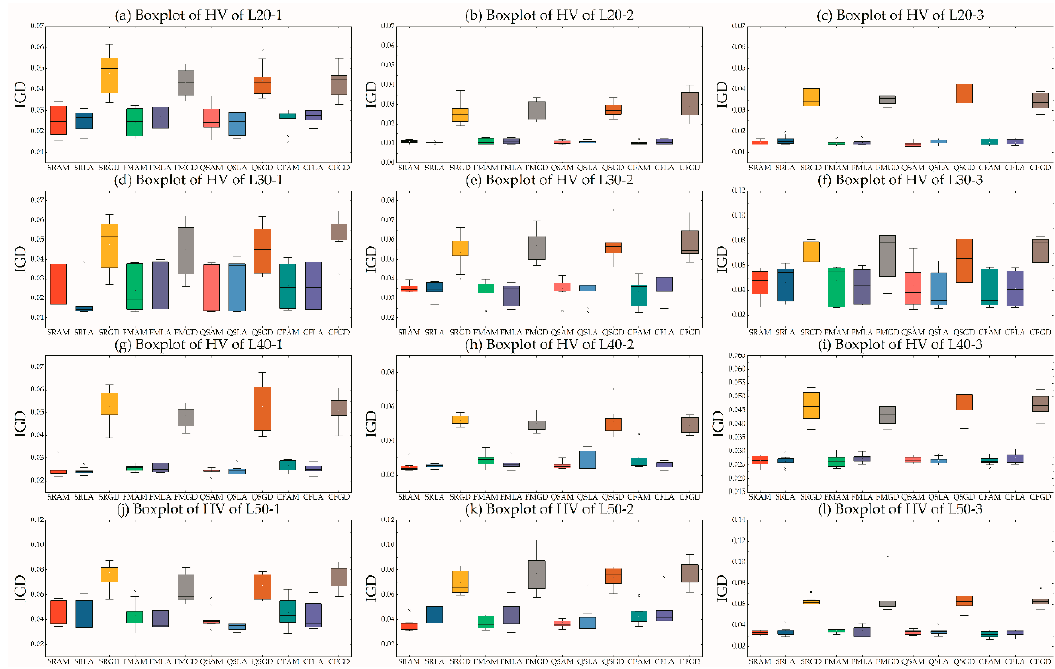
Figure 2. Boxplot of IGD values of 12 pairs.